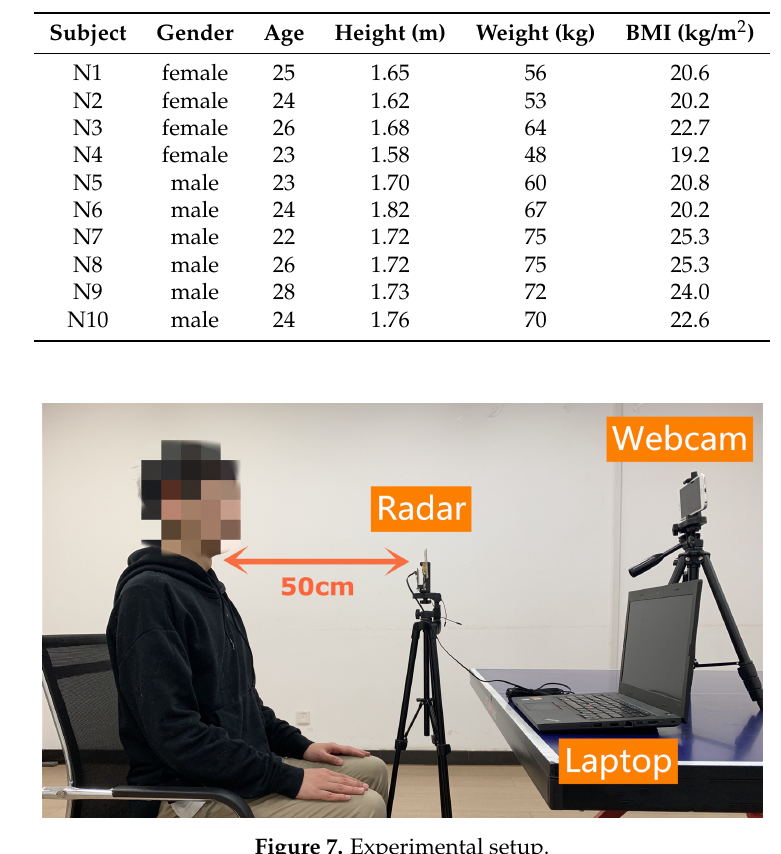
Table 2. Human subject volunteers in the experiment.